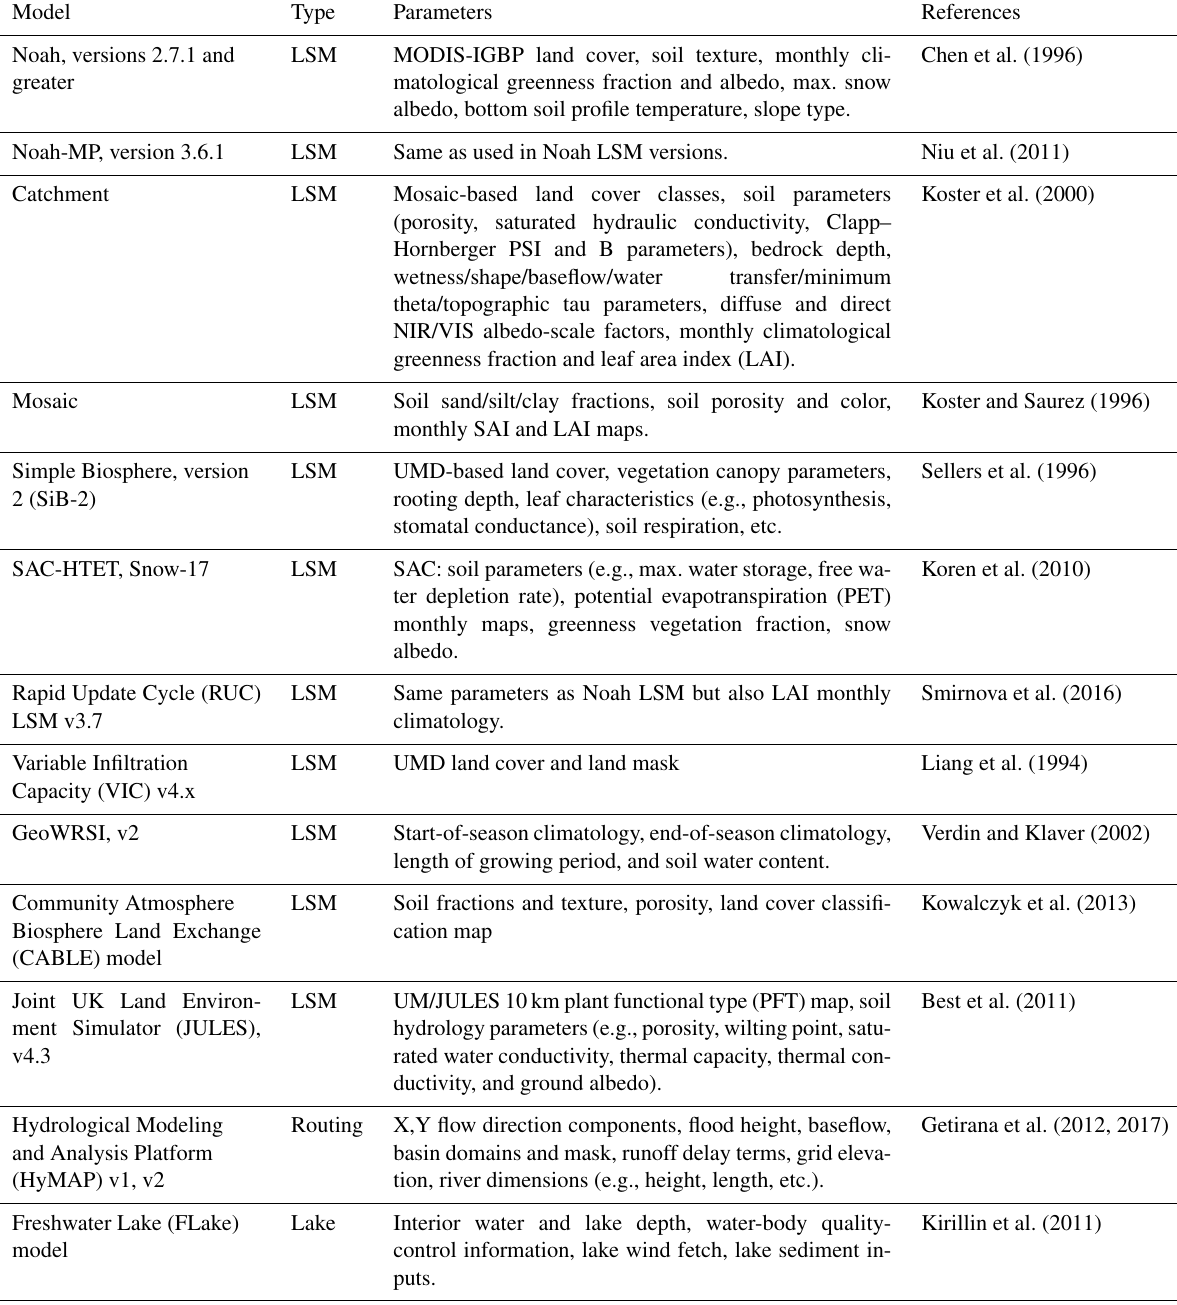
Table 1. LSMs and some of their parameters supported in LDT. Note that several LSMs use the land cover type and/or the soil texture type for each tile within LIS in combination with a lookup table to generate vegetation or soil parameters for that